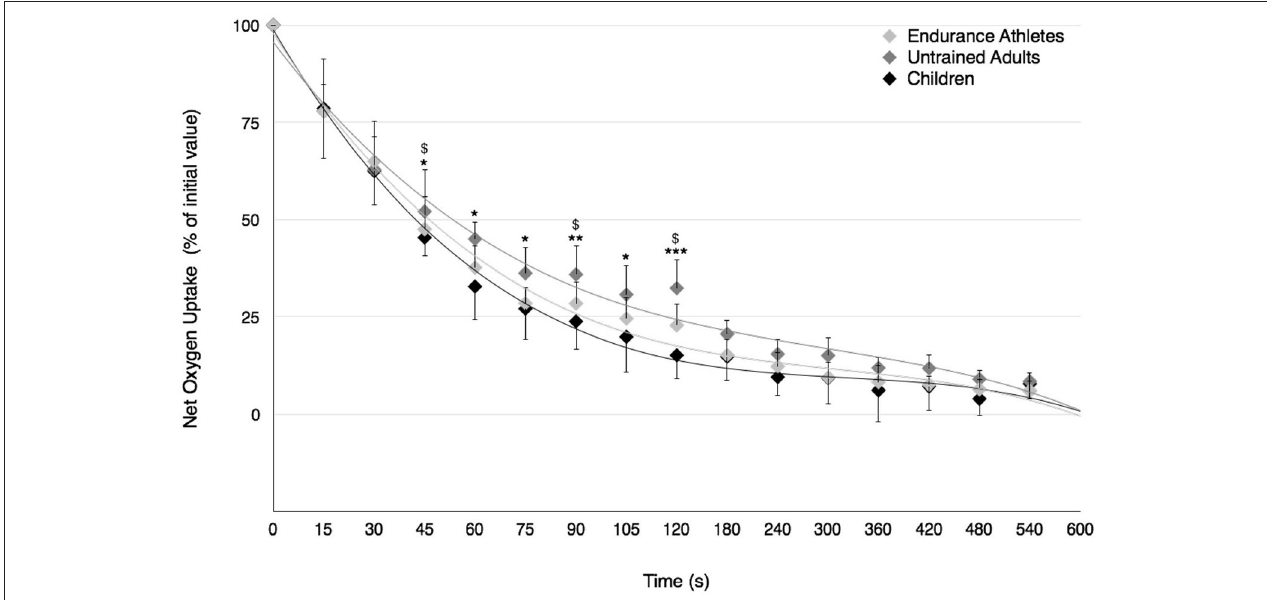
FIGURE 4 | Recovery of net O 2 uptake after the Wingate test in prepubertal children, untrained adults and well-trained adult endurance athletes. Values were expressed as percentage of initial values. *, **, ***Significantly different at p < 0.05, p < 0.01, and p < 0.001, respectively, between children and untrained adults. $ Significantly different at p < 0.05 between untrained adults and well-trained adult endurance athletes.